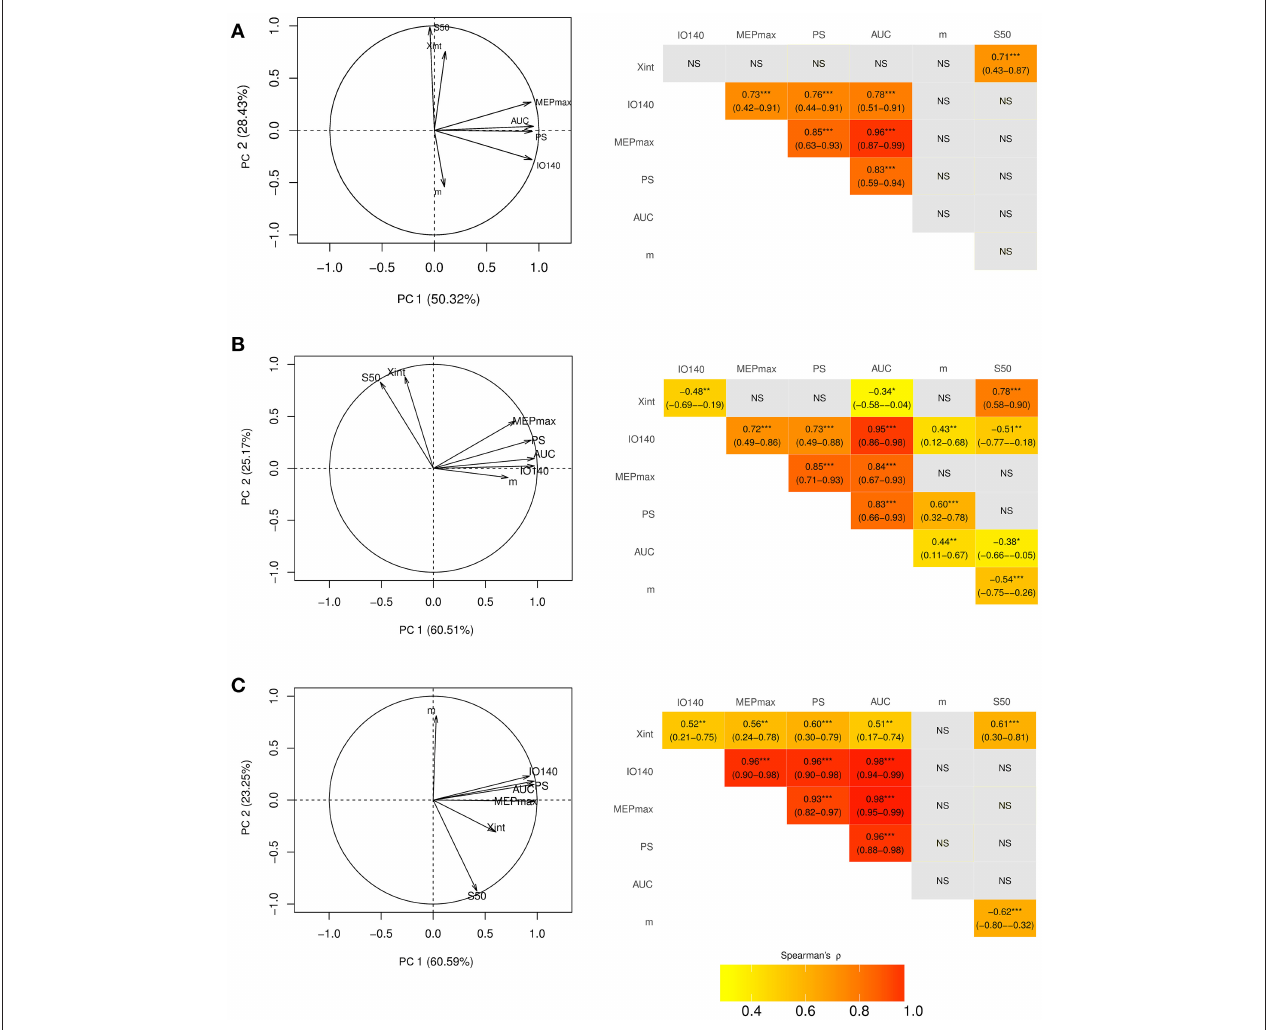
FIGURE 2 | Correlation circle created with the first two components of the principal component analysis (PCA) (left column) and corresponding correlation matrices (right column) in the dominant hemisphere of (A) healthy subjects and (B) in the unaffected and (C) affected hemisphere of stroke patients. On PCA graphs are plotted the seven electrophysiological variables on a plane spanned by PC1 and PC2. In the correlation matrices are presented the spearman correlation coefficients with their 95% Confidence Interval. X int , X intercept; IO140, Motor Evoked Potential amplitude recorded at 140% rMT; MEP max , maximum value of the sigmoid function; PS, peak slope; AUC, area under the input output curve, m, slope; S 50 , stimulus intensity needed to obtain 50% of the maximum response. *** < 0.001, ** < 0.01, * < 0.05, NS,